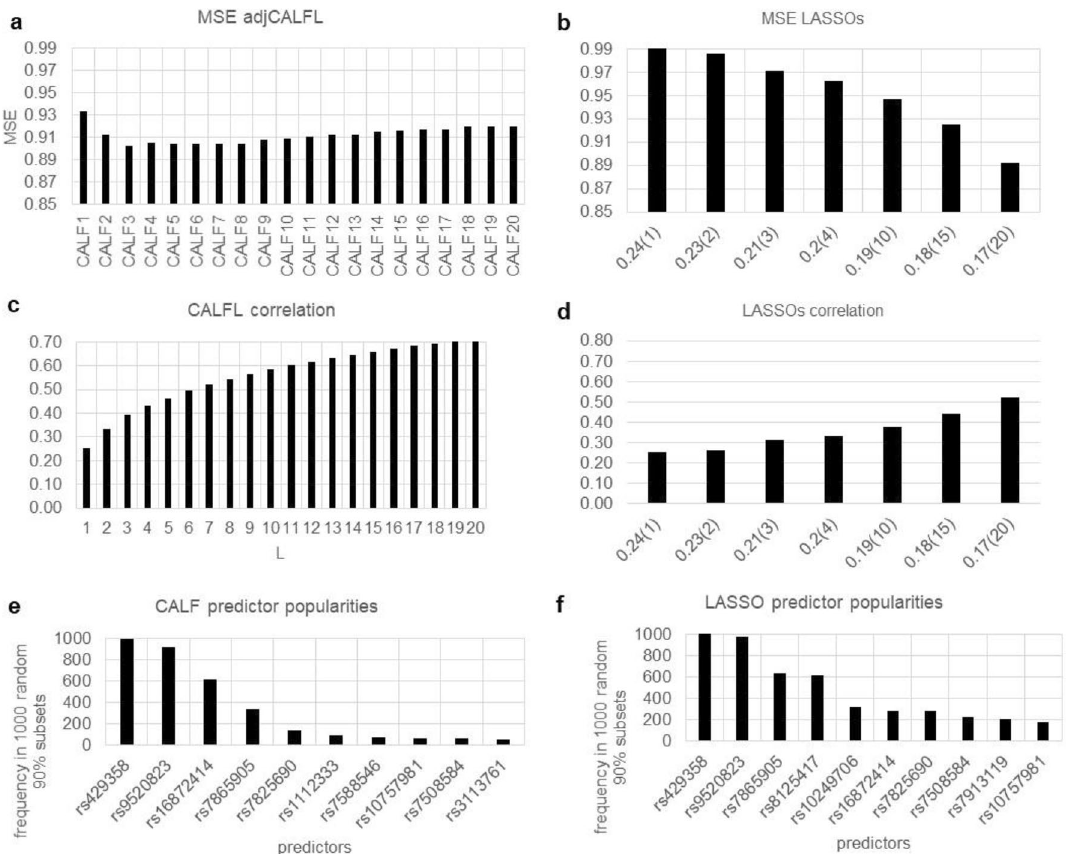
Figure 5. CALF versus LASSO for example 5. ( a ) MSE of adjCALFL reaches minimum 0.902 with three weights or 0.905 with four. ( b ) Only seven distinct numbers of nonzero weights are possible over the s scan with MSE falling from 0.991 to 0.892, including 0.962 with four weights, ( c ) The correlations for CALFL over L from 1 to 20 increase from 0.254 to 0.717 with 0.433 for CALF4. ( d ) For LASSO correlations increase from 0.254 (same as CALF1) to 0.524, including 0.332 for LASSO.2 (at four weights). ( e ) CALF popularities (same as adjCALF) for 1000 random 90% subsets of true data show a drop from more than 300 to under 150 beyond four predictors. ( f ) LASSO popularities also show a cliff beyond a slightly different choice of top four predictors, but the popularities of additional predictors are much larger, indicating ambiguity of T>C and is in exon 4 of gene APOE https:// www. ncbi. nlm. nih. gov/ snp/ rs429 358. In our normalization system (0/0 → − 1, 0/1 → 0, 1/1 → + 1, thence to z-scores), the C/C allele maps to a negative z-score. Thus, the CALF4 weight − 1 is consistent with increasing CALF4 function values with age and hence, stronger correlation with age of onset and association with risk of late-onset AD, as expected. Representative CALF4, adjCALF4, and the LASSO.2 solutions (using four predictors) are: CALF4 = − rs429358 + rs9520823 + rs16872414 − rs7865905 adjCALF4 = 0 + 0.06292 ∗ CALF4.